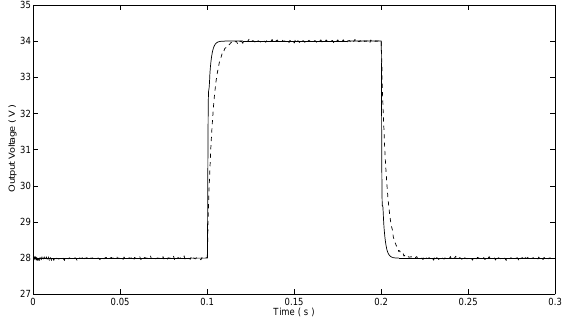
Figure 9. Output voltage of DC-DC buck converter with reference voltage change (proposed voltage regulation method ( ), PI cascade control ( −−